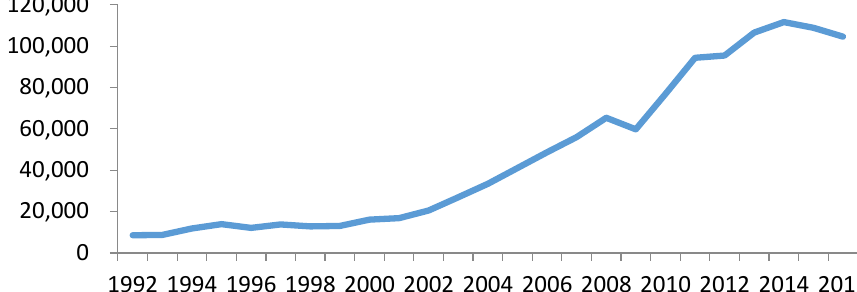
Figure 2. Value of Chinese total exports (unit: dollars in millions). Source: UN ComTrade SITC Rev. 3, 2017.